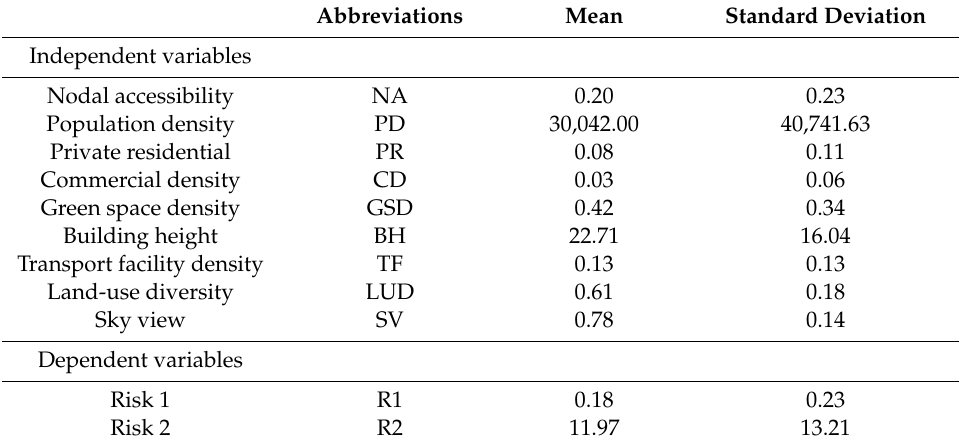
Table 2. Descriptive statistics of the independent variables and dependent